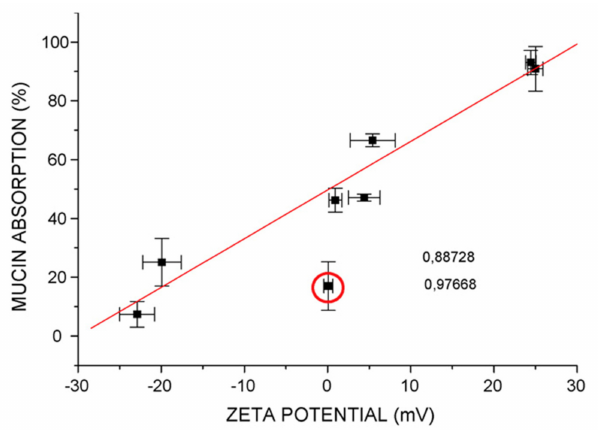
Figure 4. Effect of vesicle zeta potential on the mucoadhesive properties of chitosomes